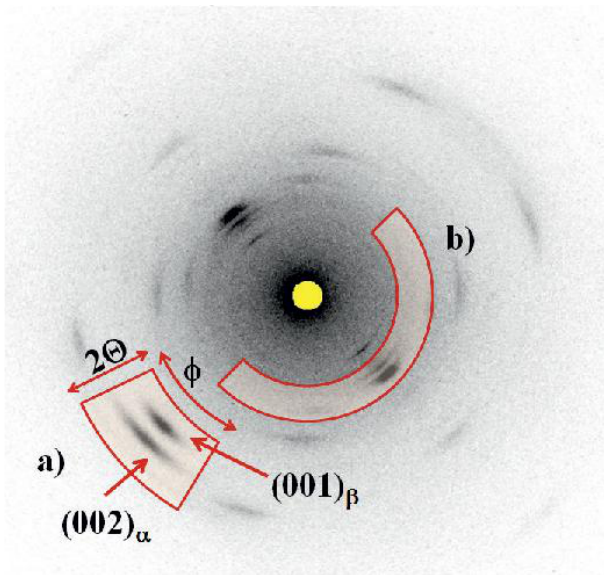
Figure 7. Wide-Angle X-Ray Diffraction (WAXD) regions of interest that are analyzed for determination of β ratio ( a ), and orientation factor of crystalline and amorphous regions ( b ).